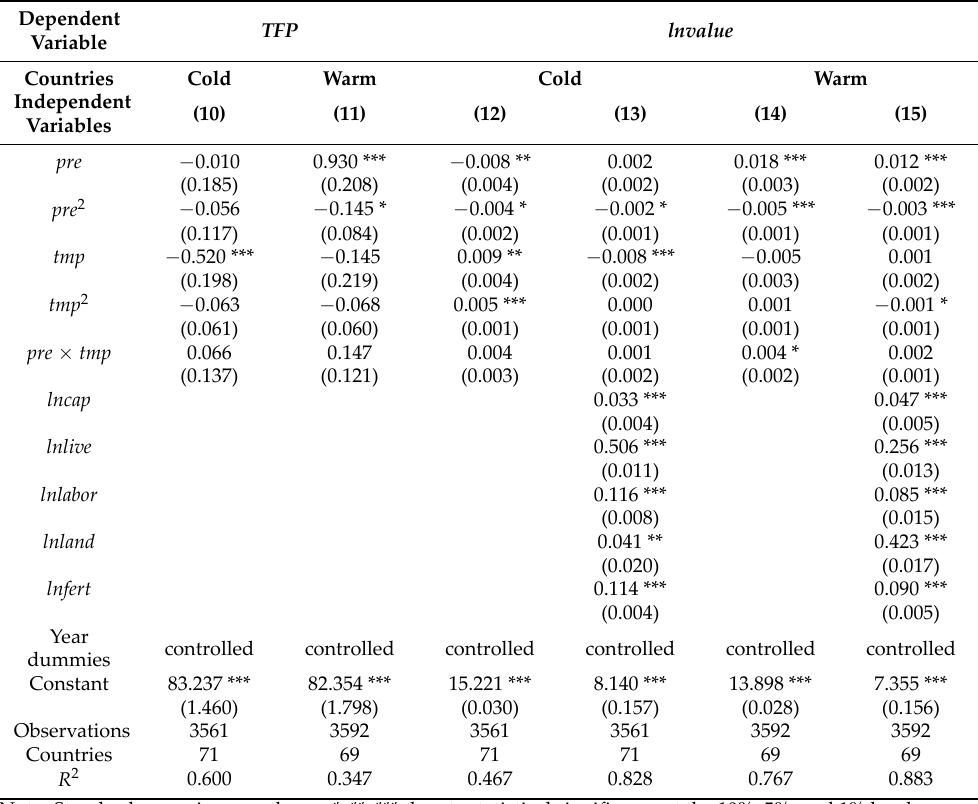
Table 6. Impact of climate change on countries with different temperature